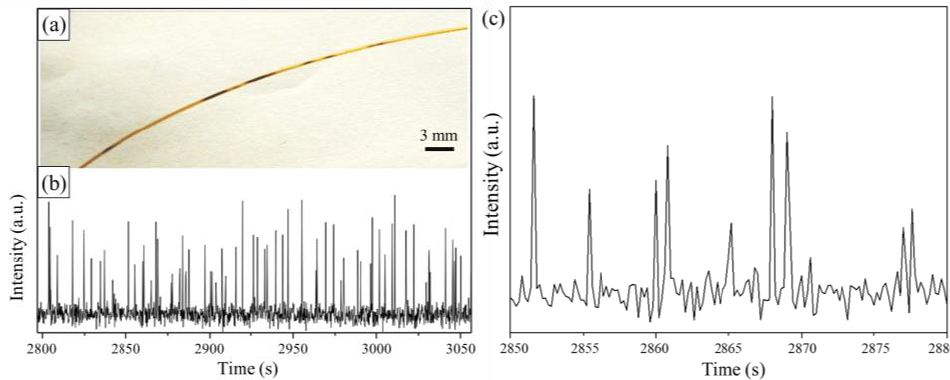
Figure 2. ( a ) Photo of a section of the capillary tube in the cooling zone. ( b , c ) Time-dependent laser scattering intensity as the TEG dispersion of GO nanosheets flows in the capillary tube. The temperature in the heating zone was 250 °C.